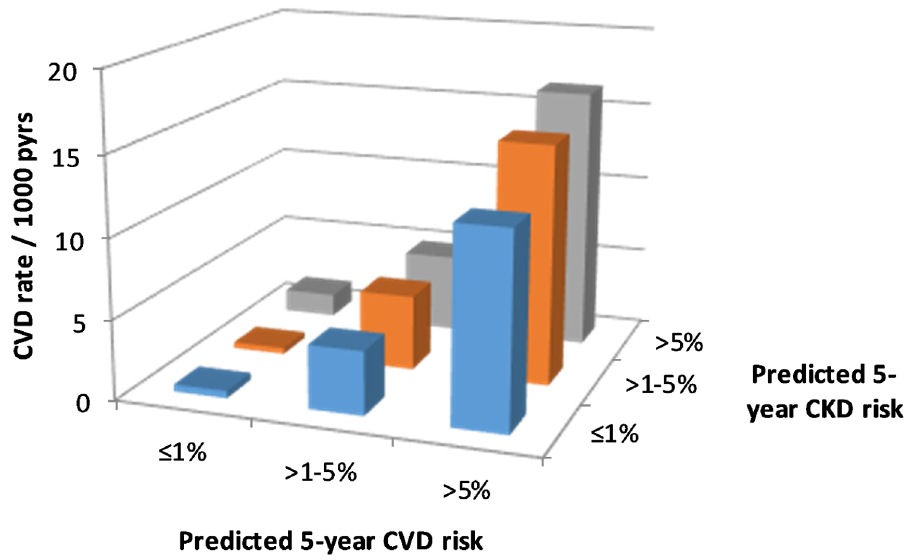
Fig 2. CVD event rates according to CKD and CVD risk. CKD, chronickidney disease;CVD, cardiovascular disease;pyrs, person-years.